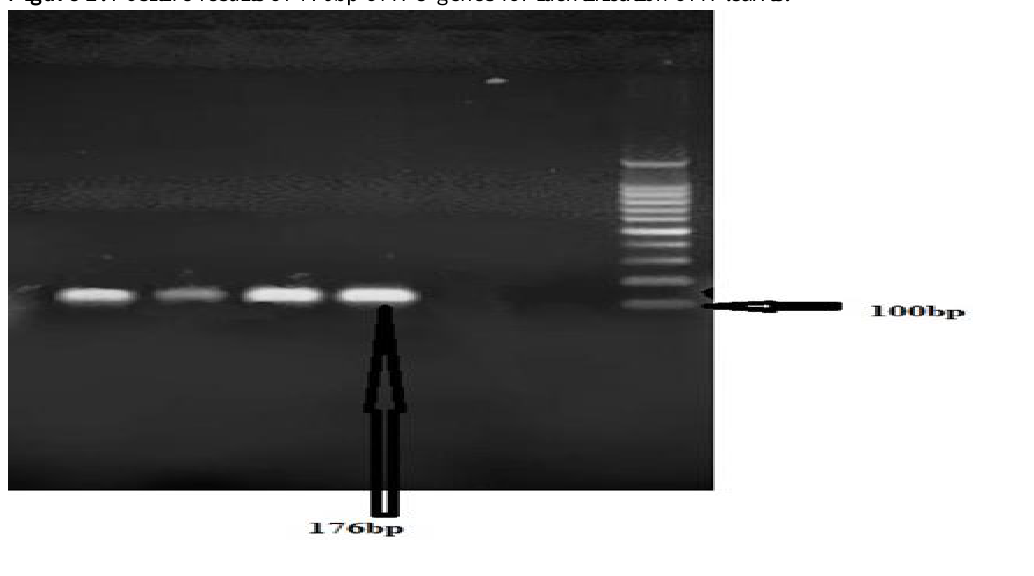
Figure 2. Positive results of 176bp of MC genes for identification of